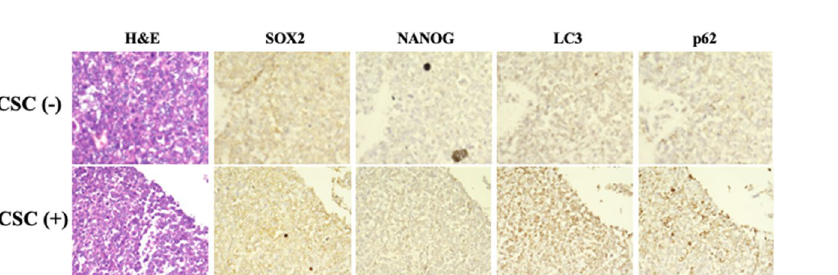
Figure 5. Immunohistochemical staining of xenografted tumor. The xenografted tumor by OCUM-12 cells were stained by cancer stem cells markers, SOX2 and NANOG. LC3B and p62 are autophagy markers. Original magnification: